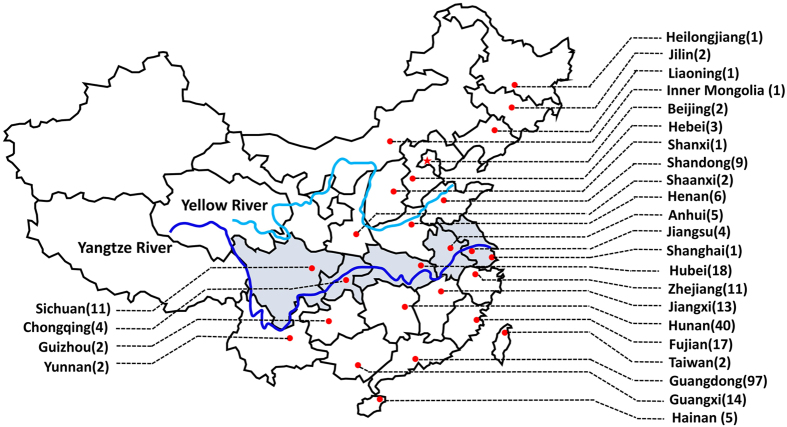
Native places of the 274 Chinese patients with citrin deficiency.By the end of February in 2016, 274 Chinese patients from 26 provinces, municipalities and autonomous regions in China were diagnosed. This figure was generated by means of the software WPS Office PowerPoint 2016, which was freely available at http://www.wps.cn/product/wps2016/. The base map was created by incrementally assembling the outlines of the Chinese administrative regions, which could be downloaded via the URL link http://www.pptstore.net/ppt_yuansu/12145.html, as a free network resource.